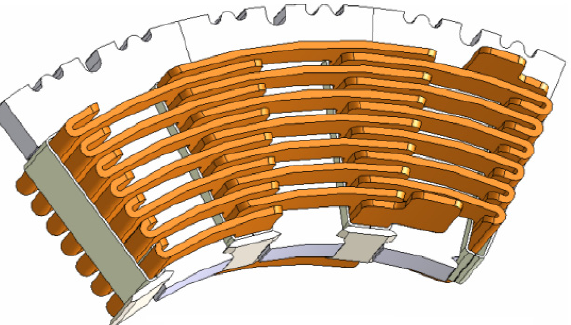
Figure 4. Radially displaced segmented laminated winding, reproduced with permission from the owner, Lund University (Sweden) [105].